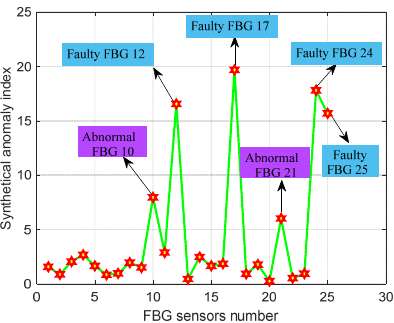
Figure 10. Experiment setup diagram of fault detection instrument for the FBG sensing system on an airplane.